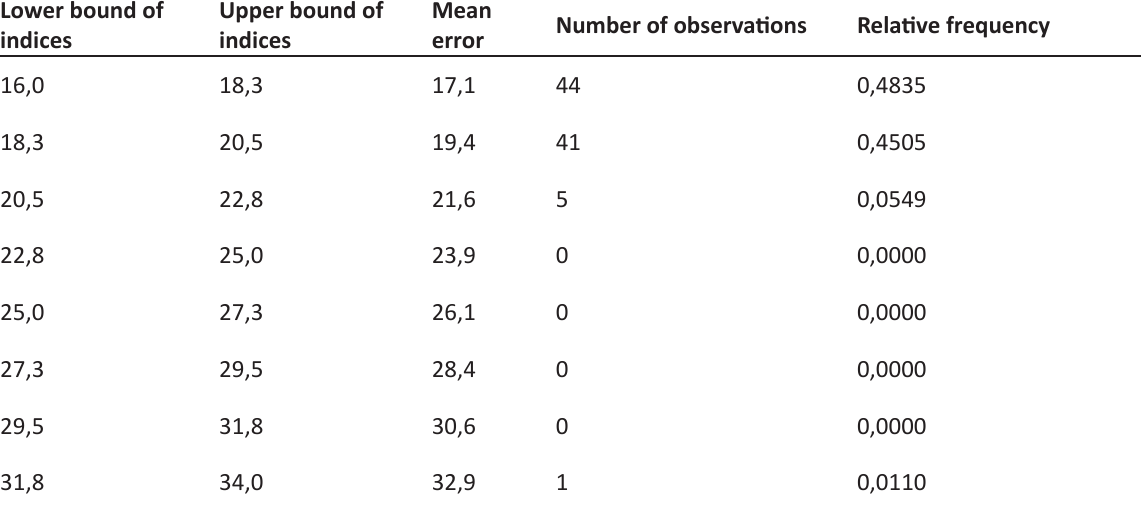
Table 6. Frequency characteristic of age Lower bound of